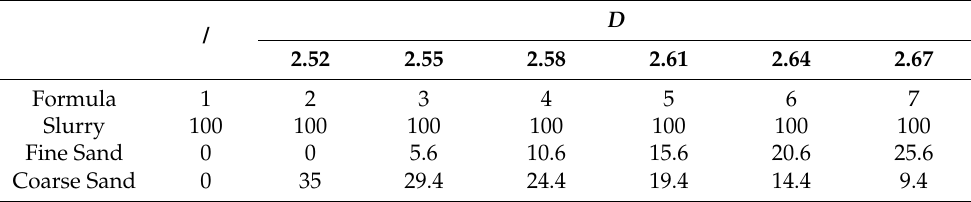
Table 2. Three component mass fractions by different fractal dimensions (sand amount 35%).